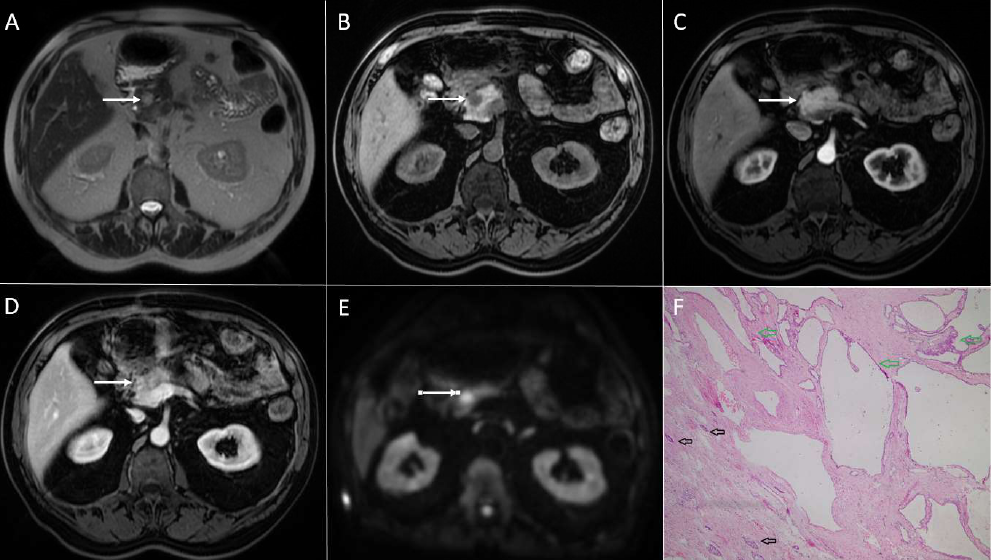
Figure 10. Serous cystadenoma in 55-year-old men. On T2-weighted image ( A ), a small round hyperintense lesion ( arrow ) is seen in the pancreatic head. The lesion is hypointense on T1-weighted fat-suppressed image ( B ), and is well-vascularized in arterial phase ( C ) with persistent enhancement in portal-venous phase ( D ). On diffusion-weighted image the lesion, ( arrow ) shows high signal intensity ( E ). Hematoxylin and eosin (H&E) staining ( F ) showed multiple microcystic spaces ( green arrows ) divided by fibro-sclerotic septas. Normal pancreatic parenchyma is also seen ( black arrows ); original magnification ×400.